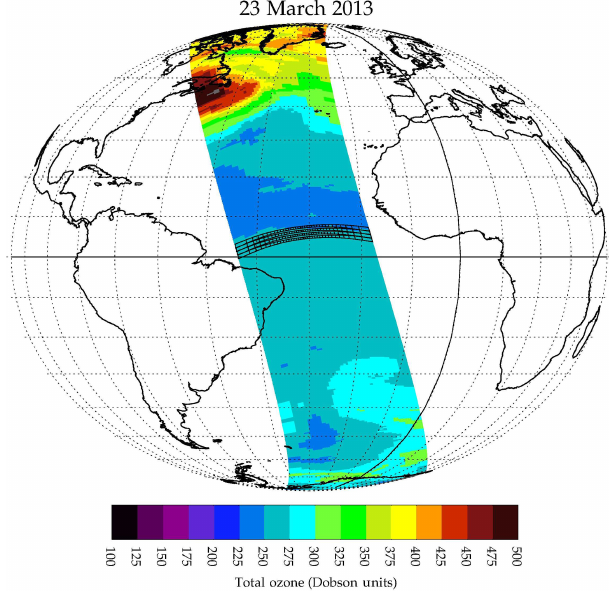
Figure 1. Each orbit of NM data measures a swath of total column ozone: 35 individual ozone measurements (see example near the Equator) are made for each scan